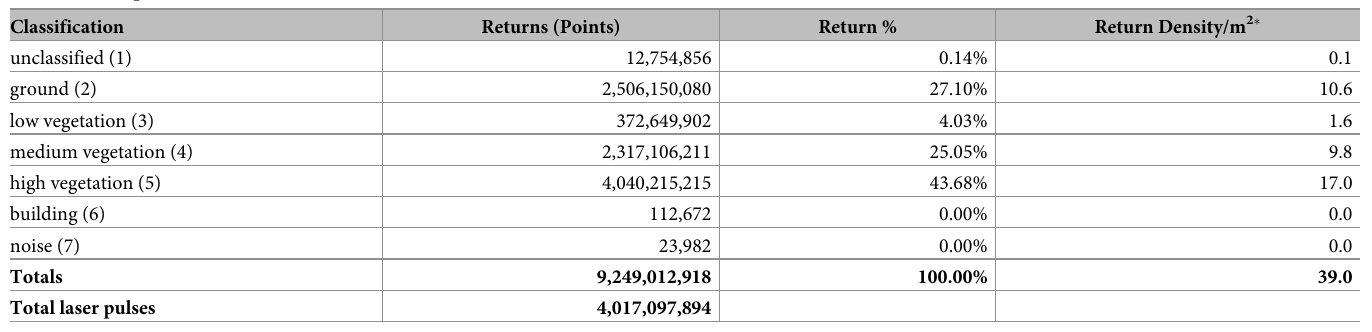
Table 2. Lidar point cloud